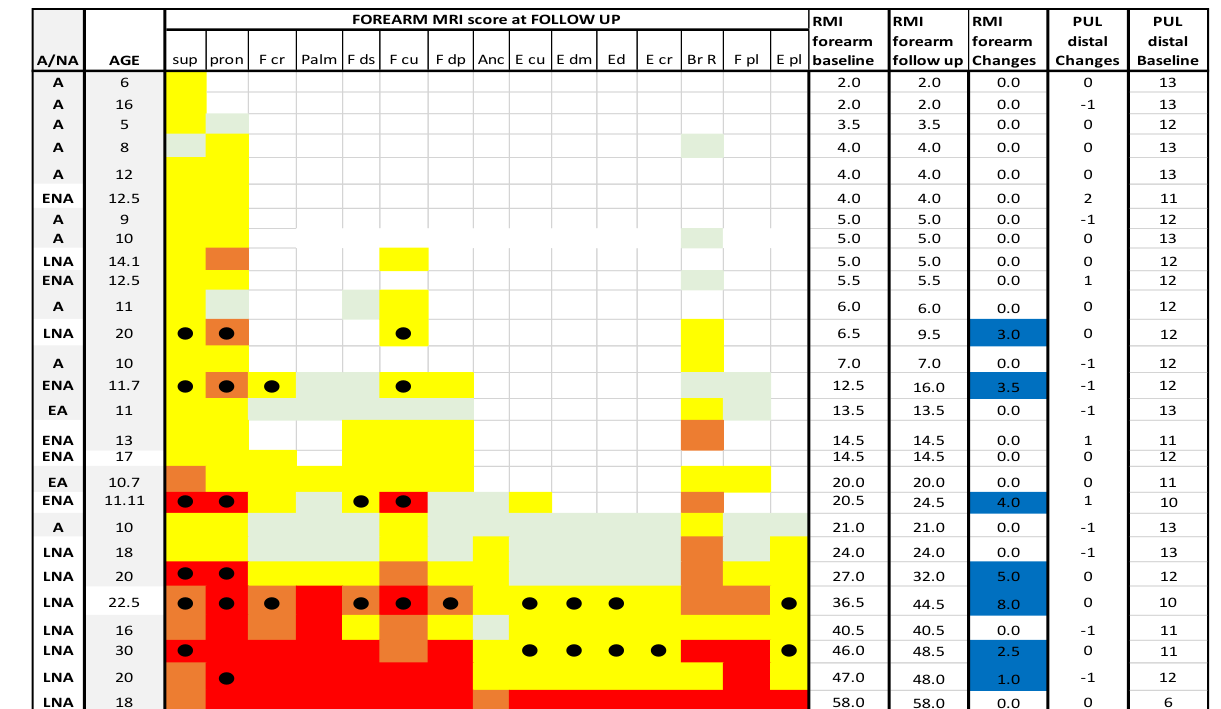
Figure 10. showed scores in muscle MRI at distal level at baseline and at follow up according to age.